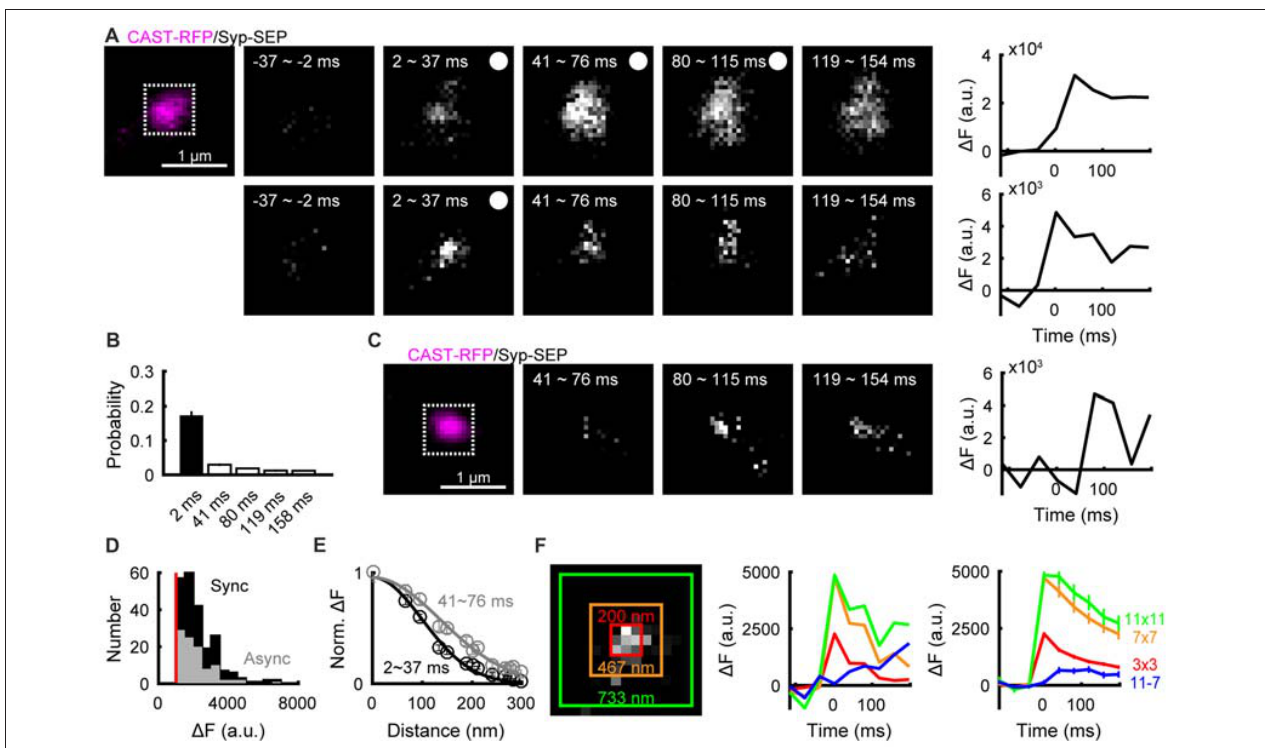
FIGURE 2 | Detection of exocytosis of a single synaptic vesicle and diffusion of synaptophysin (Syp)-super-ecliptic pHluorin (SEP) in AZLMs. (A) Images showing Syp-SEP signal increase after stimulation with 5 pulses at 50 Hz (upper) or after a single pulse stimulation (lower) in an AZLM (left, magenta), and the time courses of Syp-SEP signal intensity in 11 × 11 pixel areas (white square in the left image) after five pulse stimulation or a single pulse stimulation. The signal intensity is enhanced in the lower images compared with the upper. (B) Graph showing occurrence probability of a release event induced by a single pulse stimulation in each frame (2–37, 41–76, 80–115, 119–154, 158–193 ms) per trial throughout all experiments (10 AZLMs). (C) Asynchronous release in an AZLM (left, magenta) after a single pulse stimulation and the time course of Syp-SEP signal intensity in 11 × 11 pixels (white square). (D) Amplitude histograms of synchronous (black) or asynchronous (gray) release events in 3 × 3 pixels. (E) Distributions of Syp-SEP signal intensity in each pixel plotted against the distance from the center pixel at 2–37 ms (black) and 41–76 ms (gray). These are averaged data obtained from all synchronous events in 10 AZLMs. (F) Time courses of Syp-SEP signal intensity in 3 × 3 (red), 7 × 7 (orange), 11 × 11 (yellow green) and 11 × 11–7 × 7 (blue) pixels surrounding the center. The left graph shows data obtained in one trial in an AZLM shown in the left image, and the right one shows the averaged data from all synchronous release events in 10 AZLMs. Means and SEMS are shown in the right